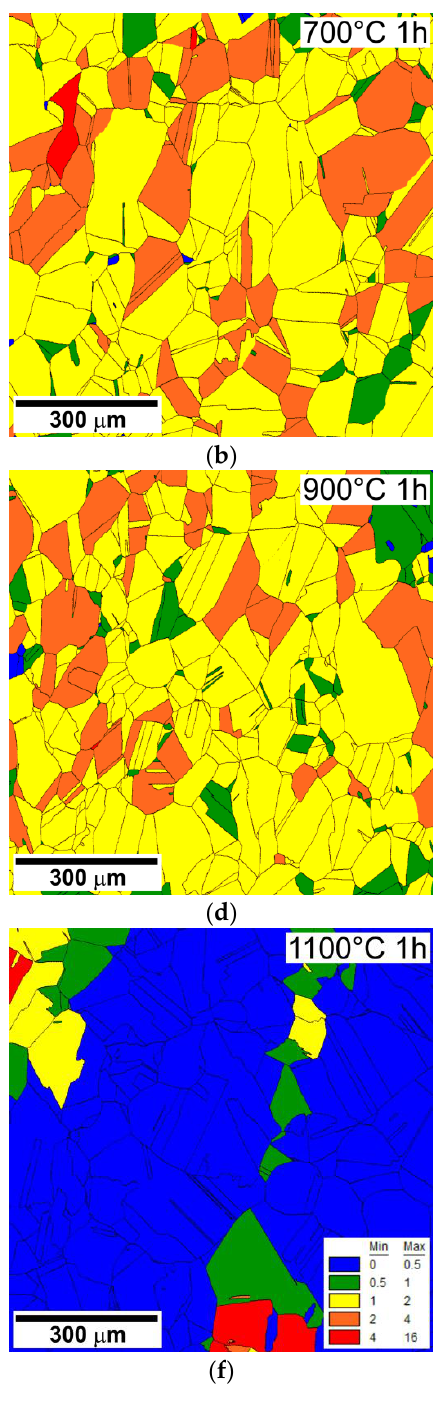
Figure 1. Grain orientation spread in the steel samples subjected to cold rolling with 5% reduction ( a ), and then annealed for 1 h at 700 °C ( b ), 800 °C ( c ), 900 °C ( d ), 1000 °C ( e ), and 1100 °C ( f ). The colour correspondence is shown in the inset in ( f ).